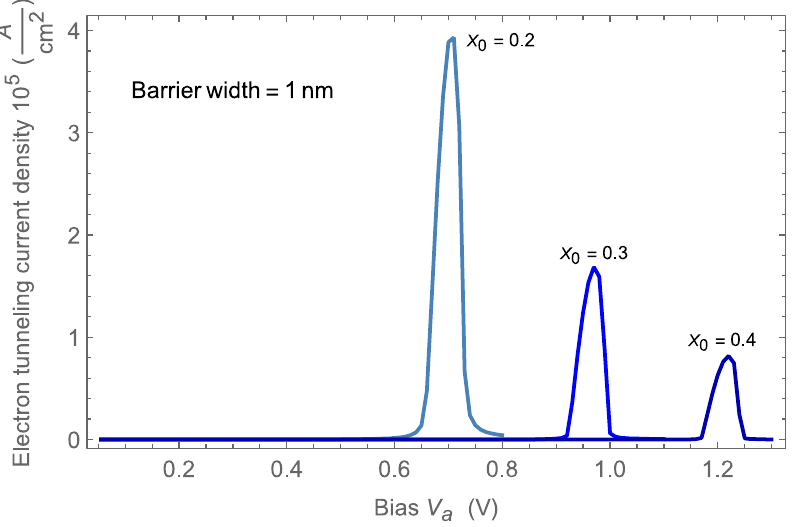
Figure 12. Current density-voltage characteristics of the electron tunneling at width barrier 1 nm.